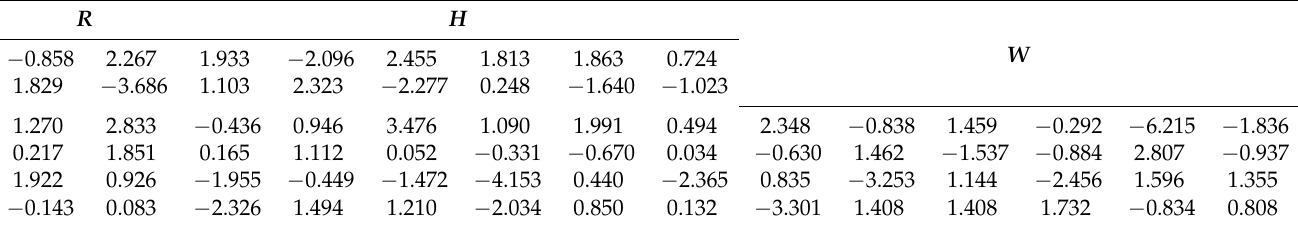
Table 3. Weights and biases of each node of the classification model. R (6 rows and 2 columns), H (6 rows and 6 columns), W (4 rows and 6 columns).